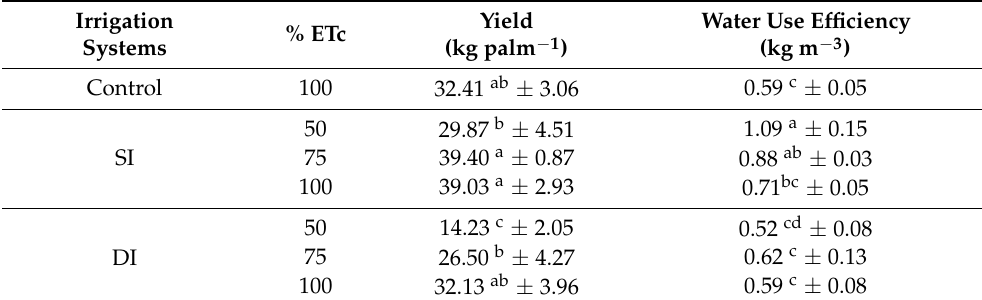
Data with identical letter(s) within each parameter are non-significant statistically at a 5% probability